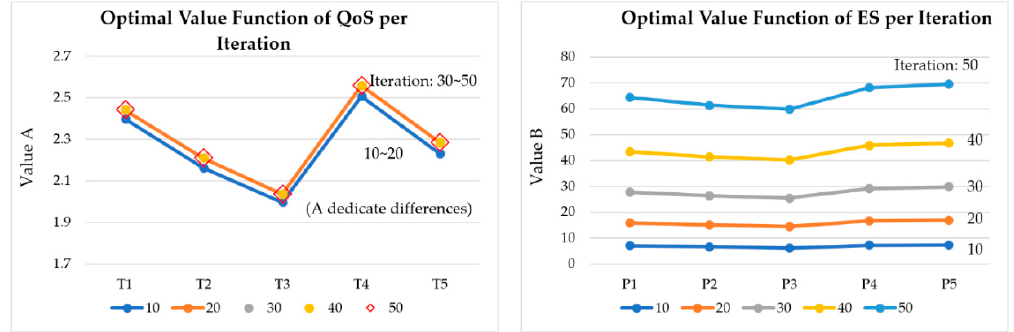
Figure 14. Estimated optimal values of QoS and energy saving per iteration.